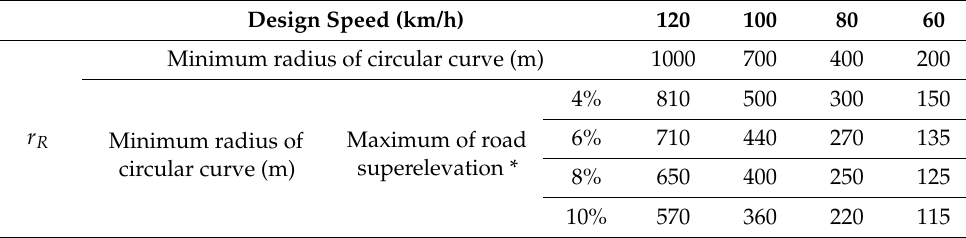
Table 4. Relationship of vehicle’s design speed and road’s radius of circular curve.